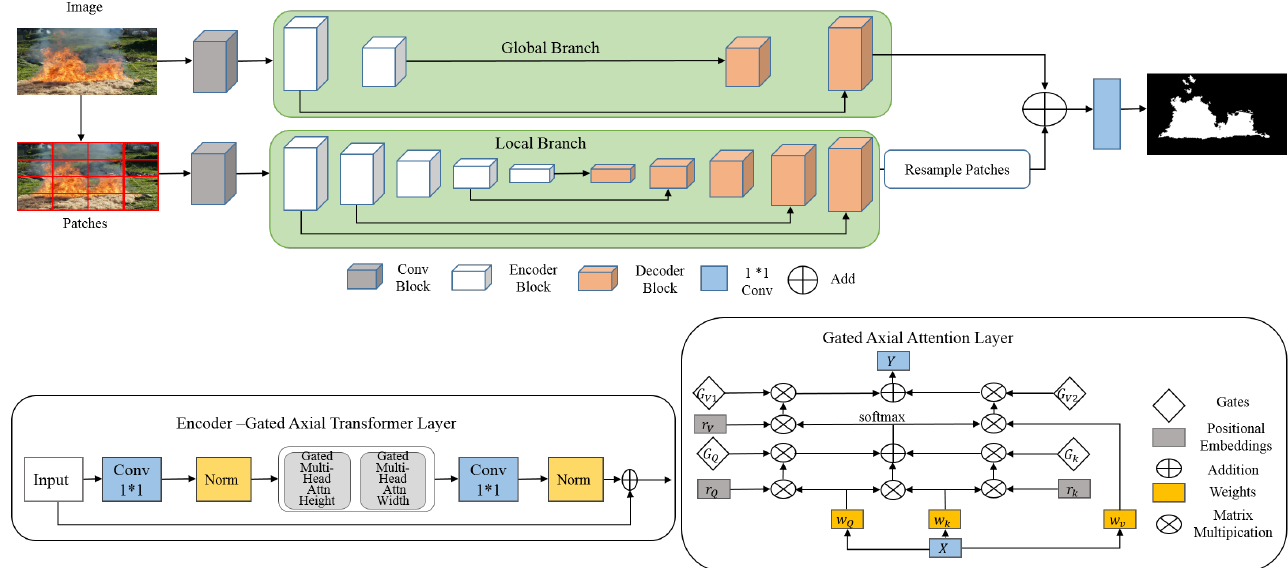
Figure 2. The proposed MedT